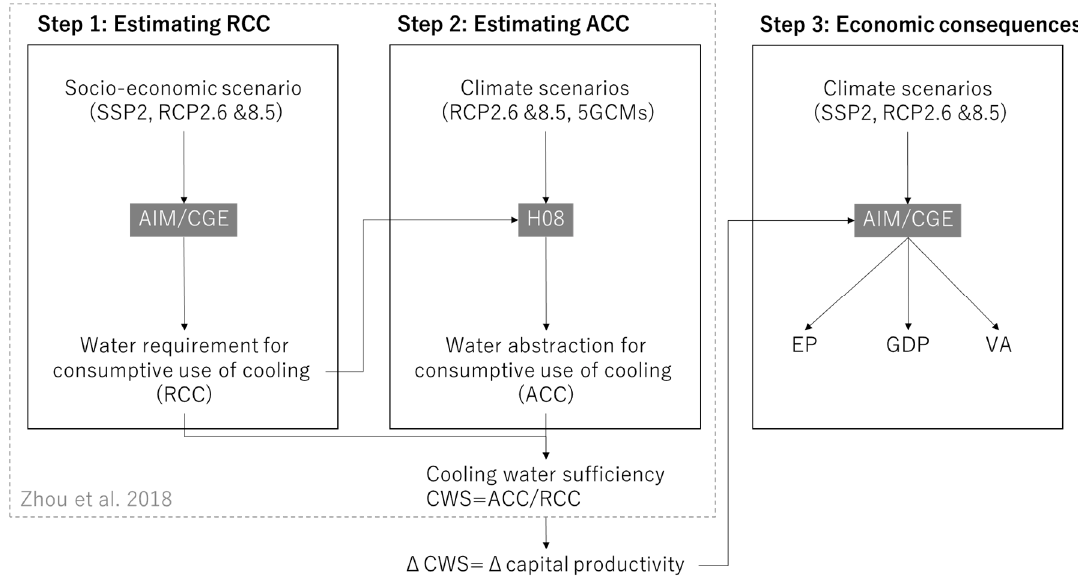
Figure 1. Schematic of the models and data flows. AIM/CGE and H08 denote the Asia-Pacific Integrated Model/Computable General Equilibrium (AIM/CGE) and the H08 global hydrological model, respectively. SSP, RCP, GCM, EP, GDP, and VA denote Shared Socioeconomic Pathway, Representative Concentration Pathway, Global Climate Model, Electricity Production, Gross Domestic Production, and Value Added, respectively.